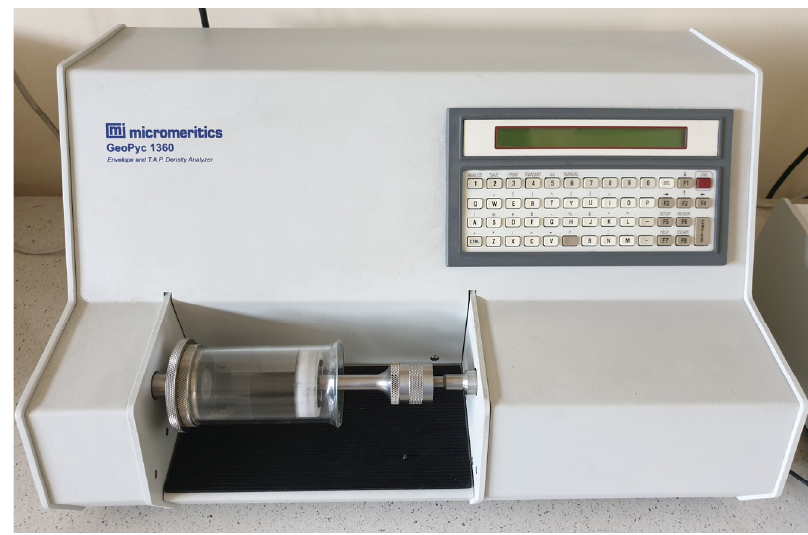
Figure 3. GeoPyc 1360 density determination station.